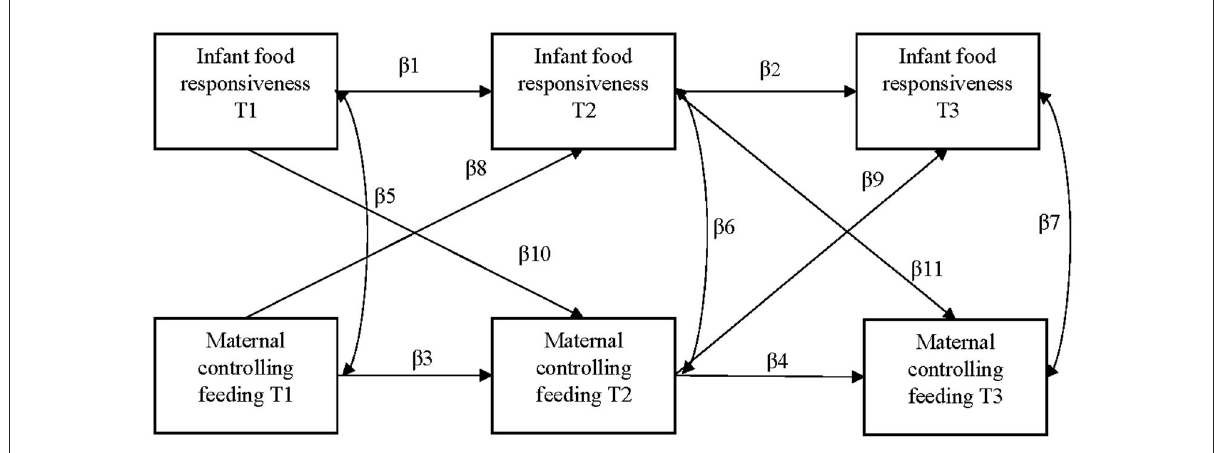
FIGURE1 Conceptual model for longitudinal associations between maternal controlling feeding and infant food responsiveness. T1 = infant age 2 months, T2 = infant age 6 months, T3 = infant age 14